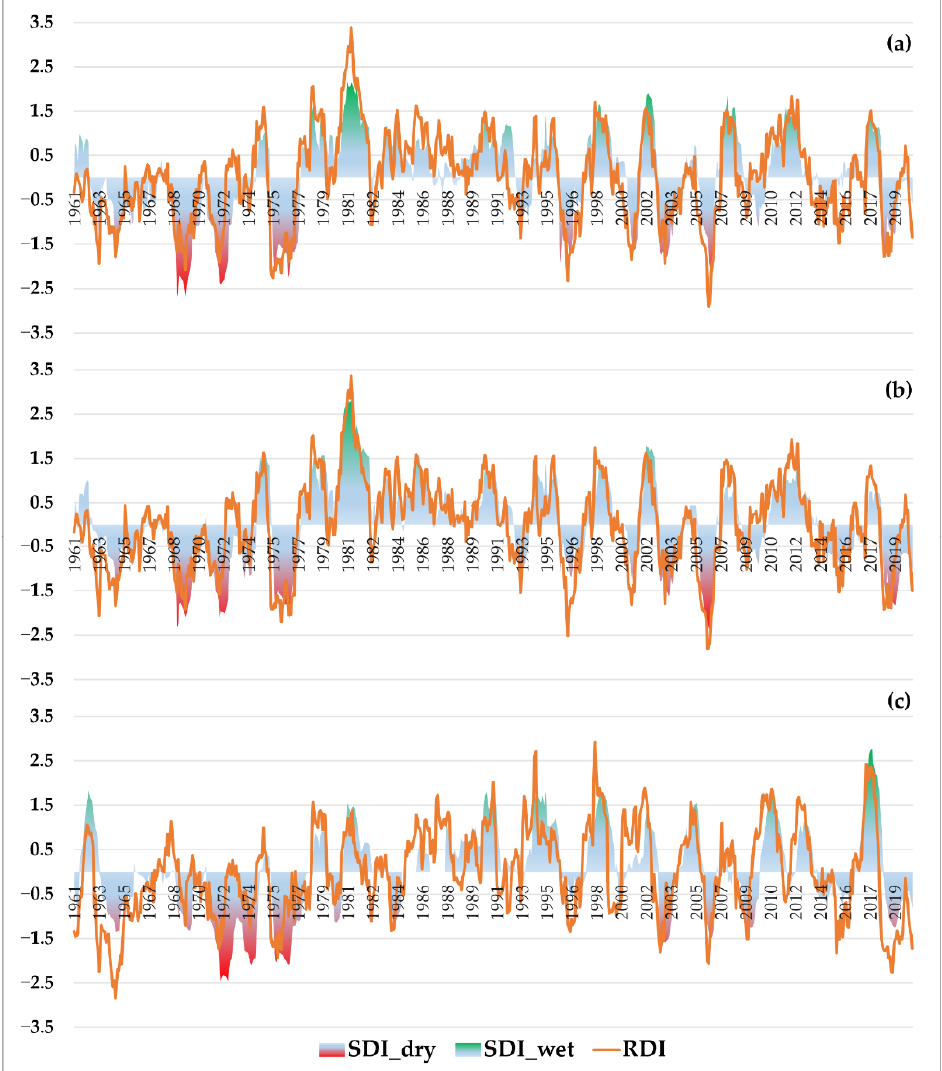
Figure 5. Values of meteorological (SPI-12) and hydrological (SDI-12) indices during the period from 1961 to 2020, in: ( a ) Minija-Kartena; ( b ) Venta-Leckava; ( c ) Šventoji-Ukmerg ė .